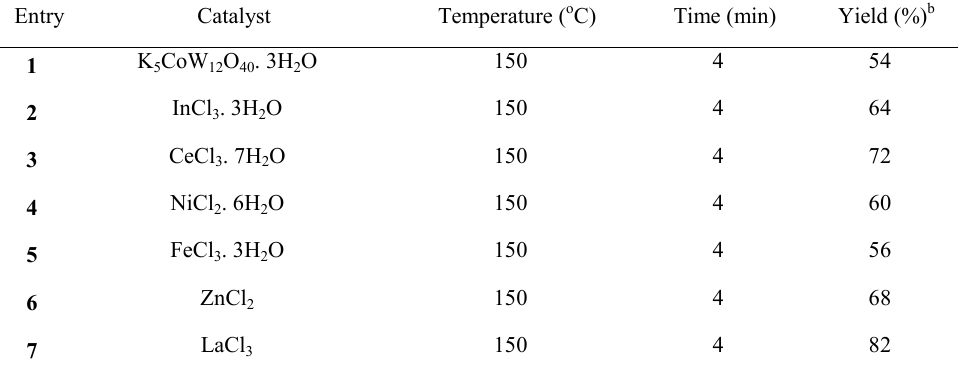
Table 1. Screening of some acidic catalysts for model reaction under microwave irradiation a